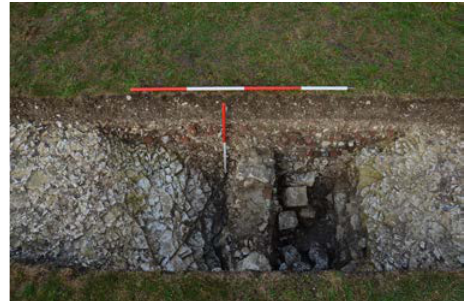
Fig. 7: The wall footings in Trench 11. The main wall cut on the right has been robbed of its stones and the carved chalk blocks of the retaining wall (centre) have collapsed into the resulting void. Note the difference in the disposition of the demolition rubble either side of the wall.